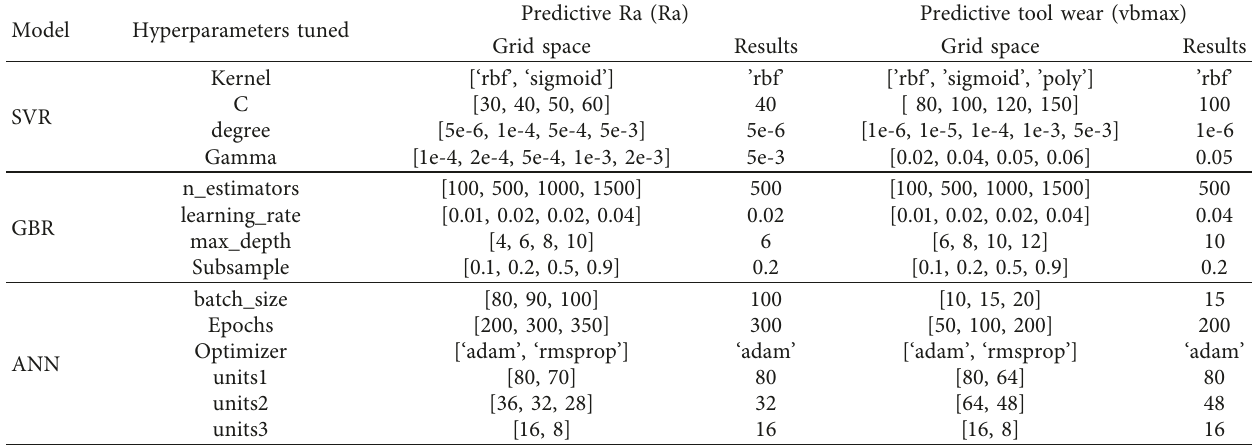
Table 4: Hyperparameters for machine learning models.